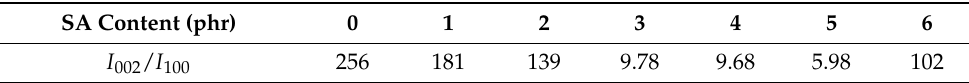
Figure 4. DSC curves of ( a ) cooling and ( b ) secondary heating of composites.